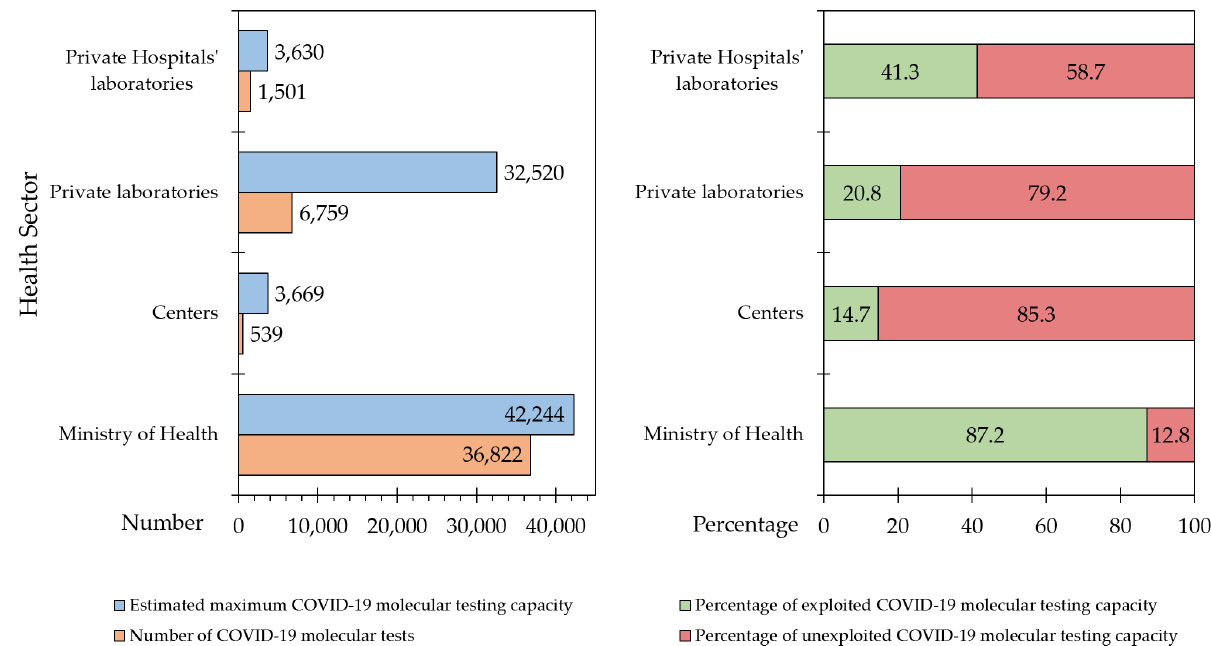
Figure 3. Estimated unexploited COVID-19 testing capacity per health sector in relation to the actual number of tests and full testing capacity. Centers: University/research/specialized center; COVID-19: Coronavirus disease 2019.